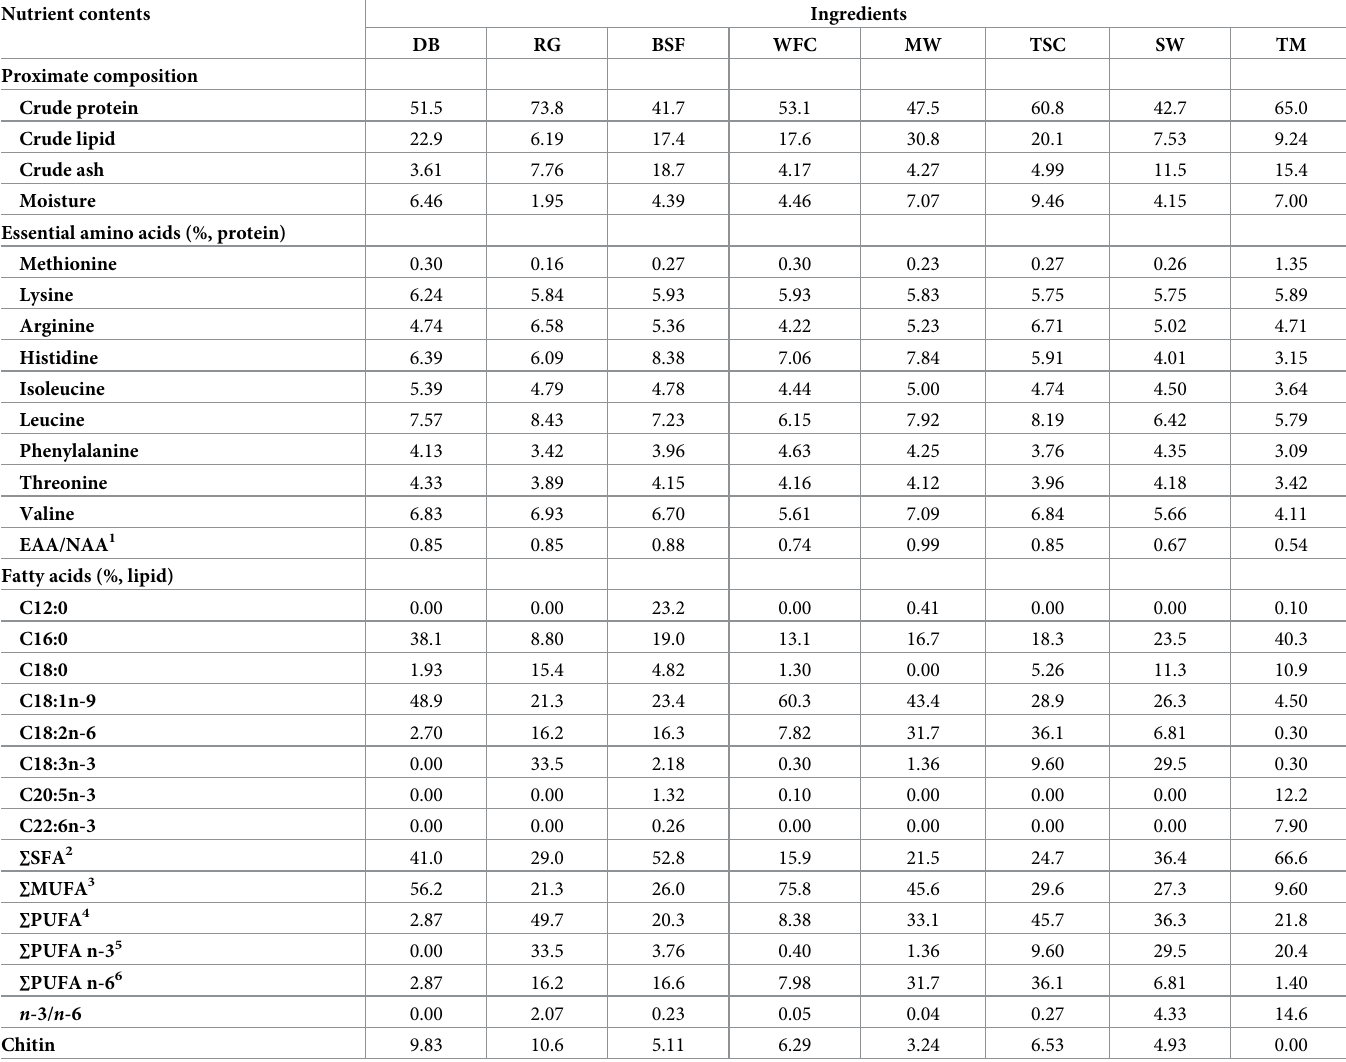
Table 1. Nutrient compositions (%, dry matter) of the seven insect meals and tuna byproduct meal for the digestibility and feeding trial of Pacific white shrimp ( Litopenaeus vannamei